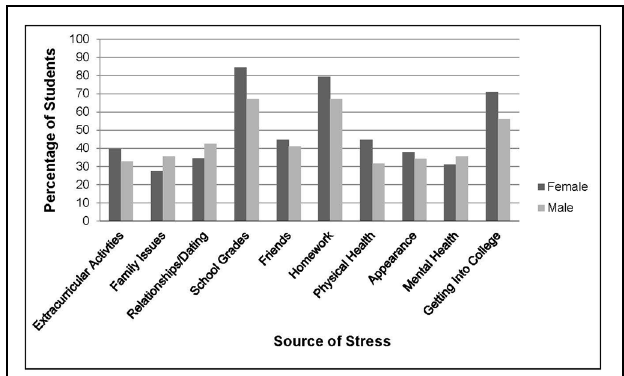
FIGURE 1 | Percentage of students reporting “somewhat” or “a great deal” of stress various